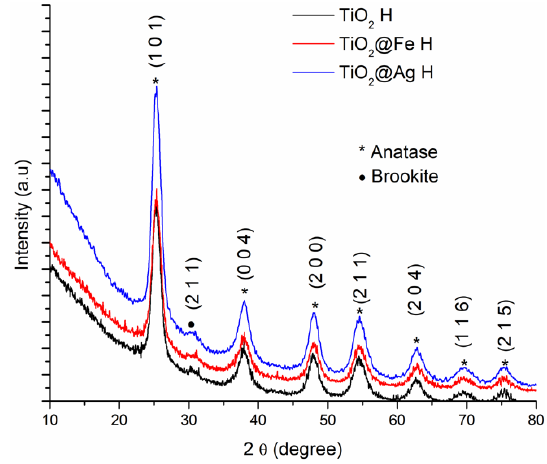
Figure 3. XRD analysis corresponding to the samples obtained by sol-gel (SG) method.